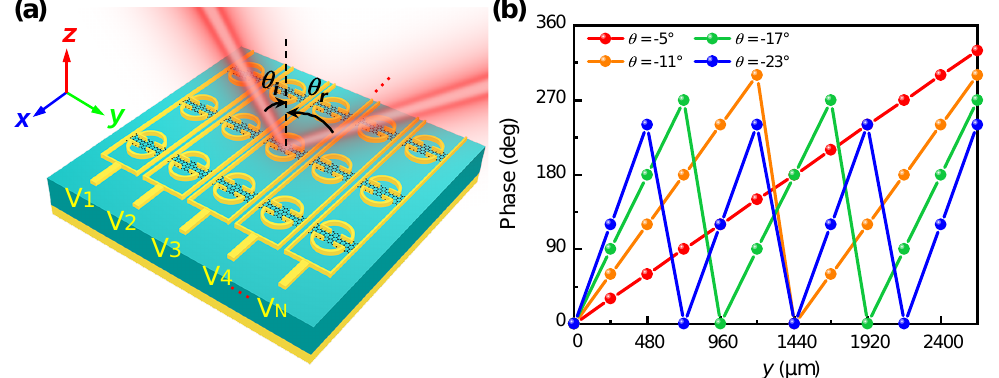
Figure 5. ( a ) Schematic of the phased array structure for achieving dynamic reflection beam steer- ing; ( b ) reflection phase distributions of the designed phased array for achieving four specific deflection